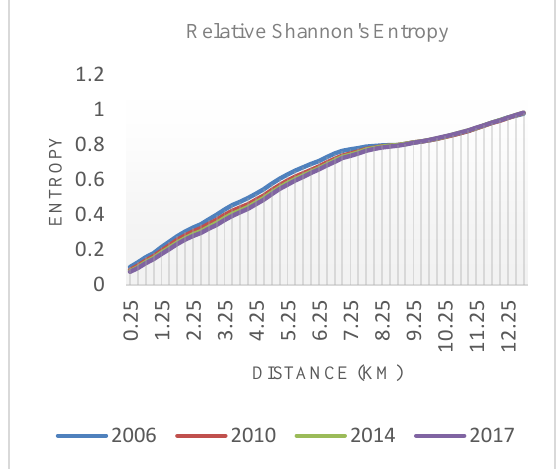
observed in the outer part of the city.